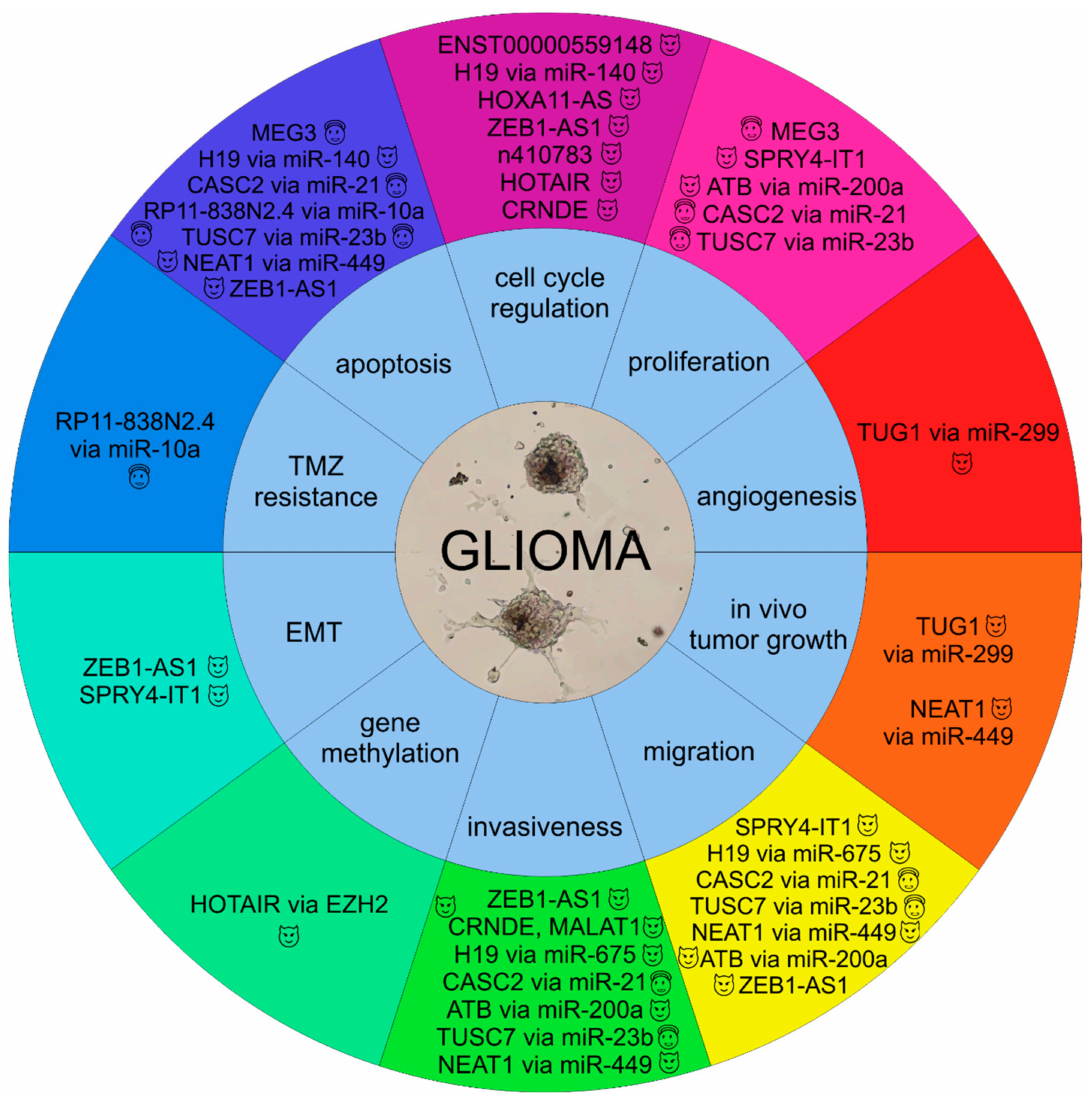
Figure 1. Involvement of selected lncRNAs in the molecular pathology of gliomas ( , oncogenic lncRNAs; , tumor suppressor